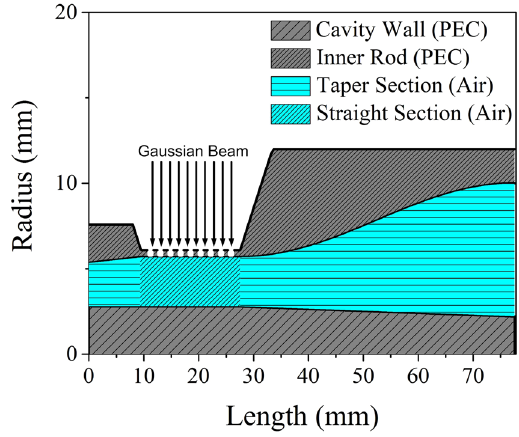
Figure 4. Geometry of the QO-mode generator.